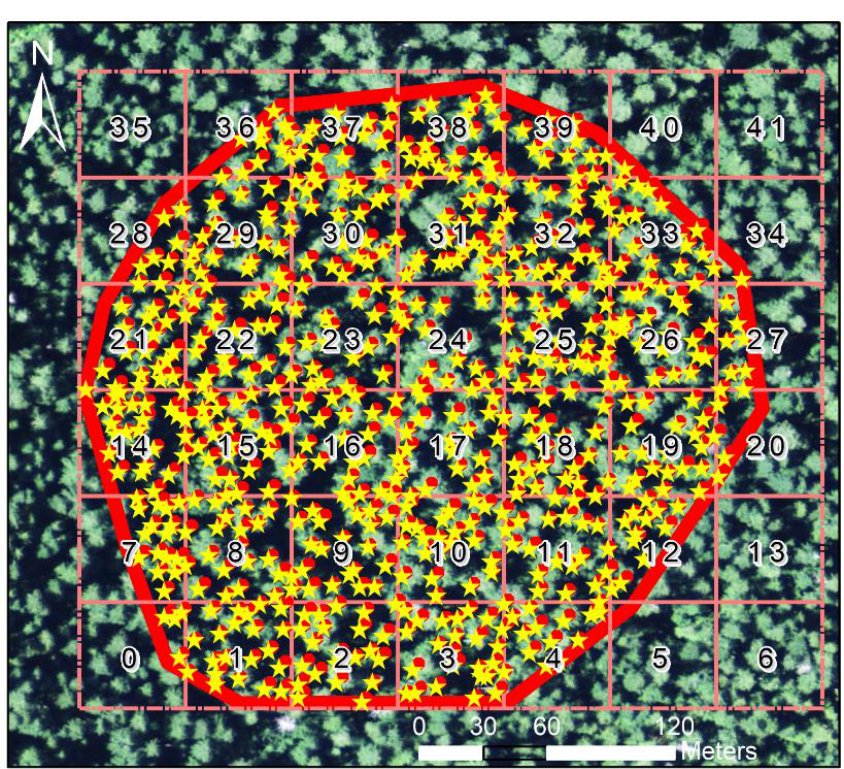
Figure 8. The 50 m grid with their corresponding ID used to georeference all the trees. The yellow starts are the 641 trees extracted from above, the red dots represent the georeferenced trees segmented from georeferenced images.